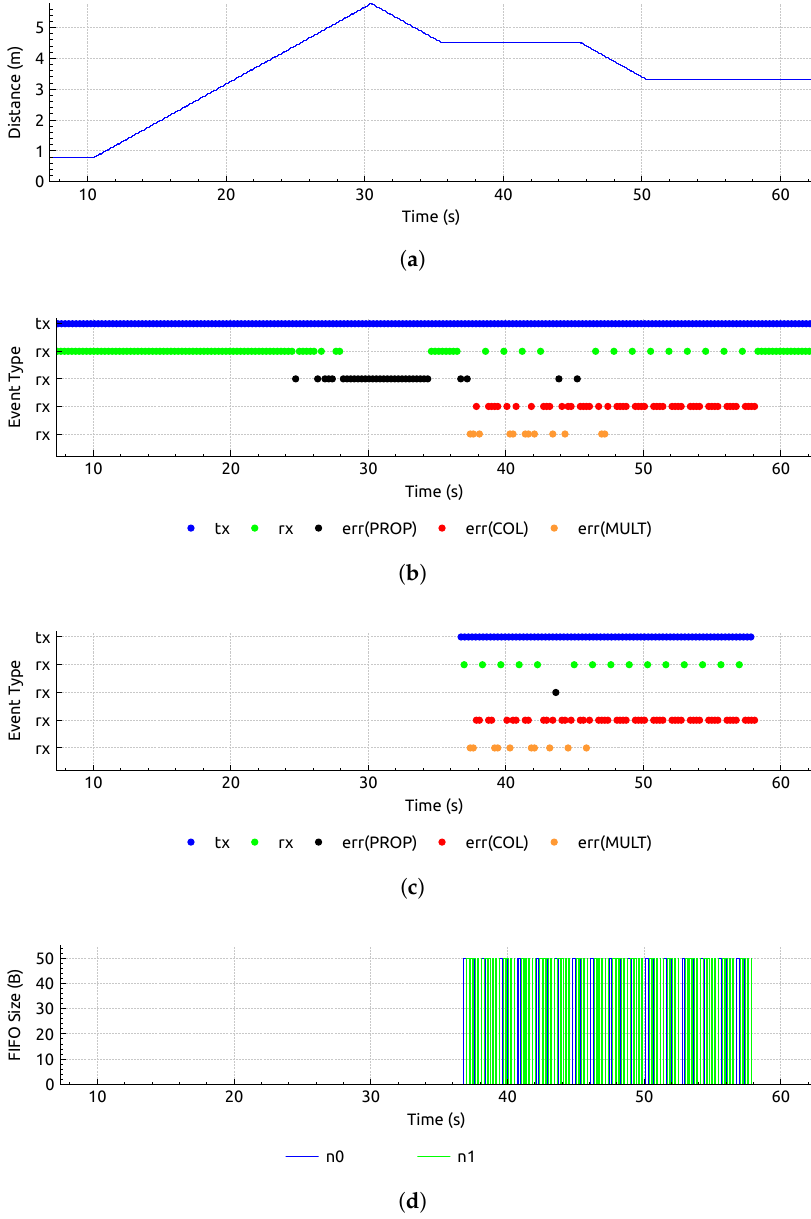
Figure 3. Collision of packets when two ROVs are transmitting at the same time. Transmitted packets (tx), successfully received packets (rx), packets lost due to attenuation (err(PROP)), packets lost due to collision (err(COL)) and packets that have suffered attenuation and collision (err(MULT)) are presented: ( a ) distance between the ROVs during the experiment; ( b ) flux of packets of the ROV that is transmitting continuously; ( c ) flux of packets of the ROV that starts a transmission while the other ROV is transmitting; and ( d ) occupation of the transmission FIFO